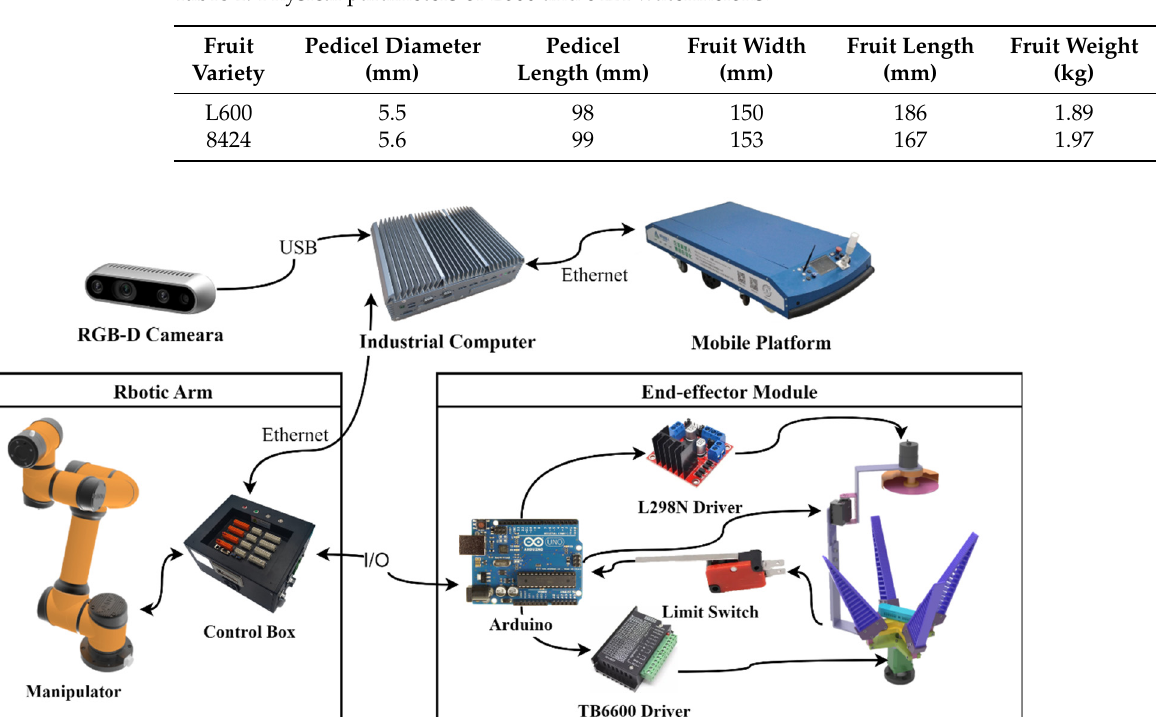
Table 1. Physical parameters of L600 and 8424 watermelons.